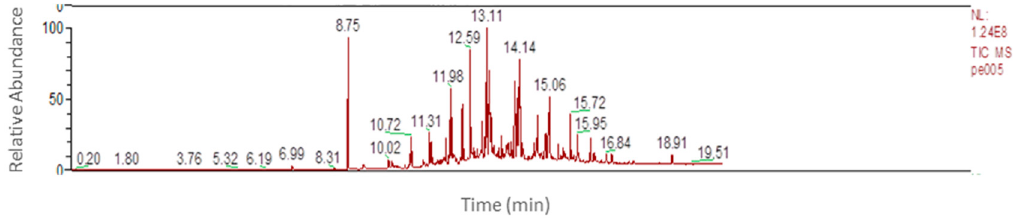
Figure 7. Chromatograms obtained with headspace solid-phase microextraction (HSSPME) on untreated LDPE.